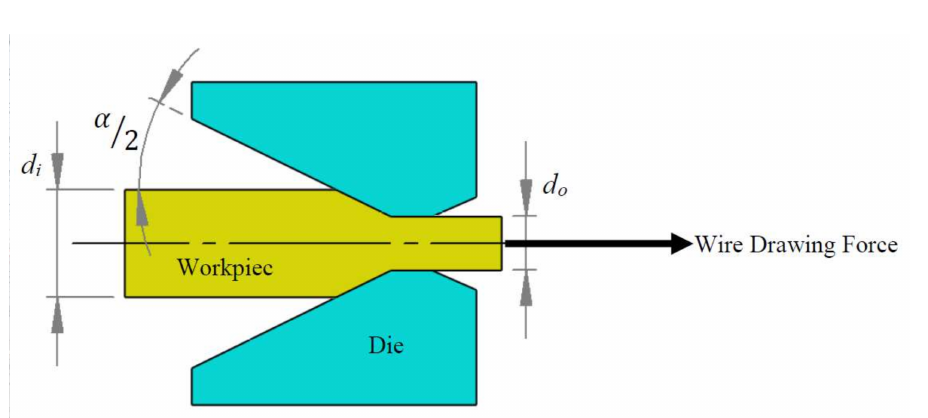
Figure 1. Schematic representation of a typical pass in the wire drawing